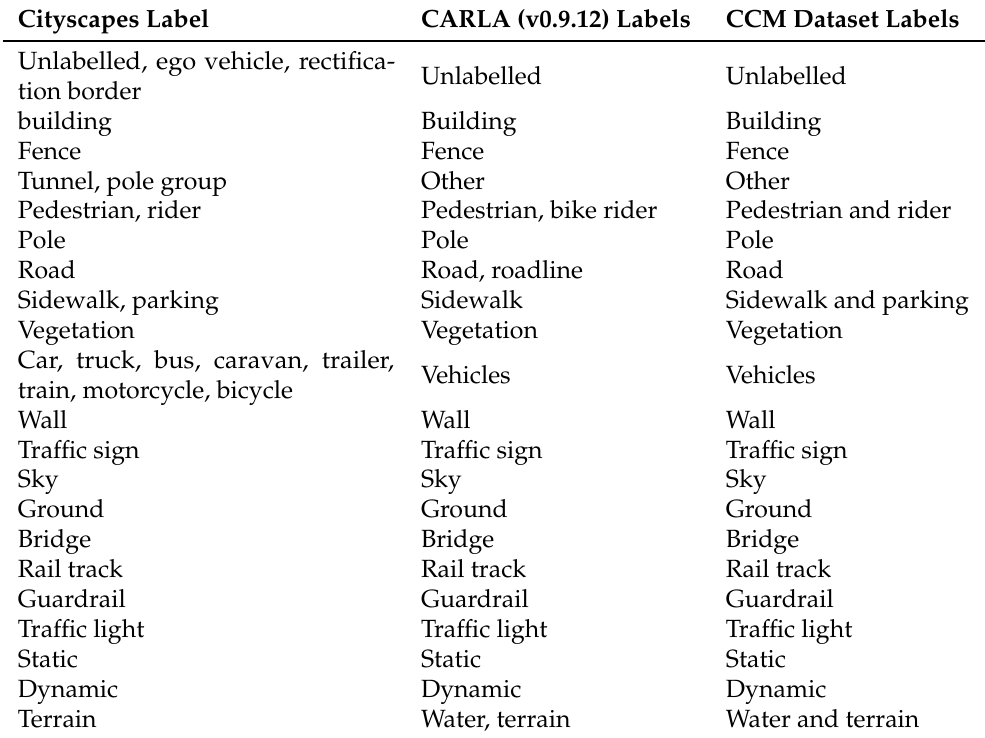
Table 2. Labelling for experiments with CCM